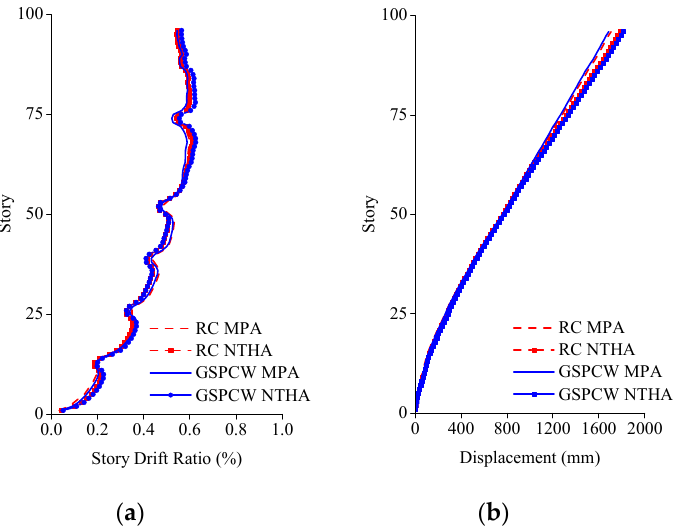
Figure 21. Comparison of story deformation between the RC and GSPCW models: ( a ) story drift ratios; ( b ) peak story displacements.